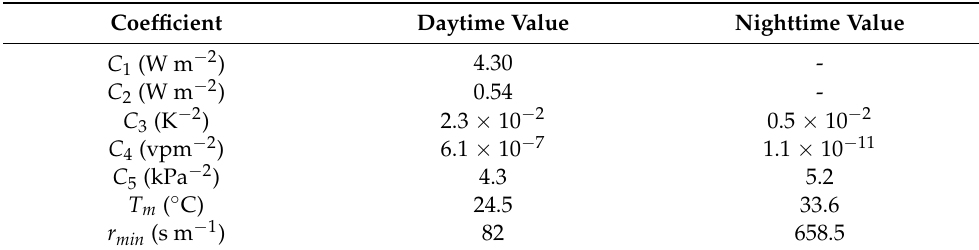
Table 1. Internal resistance parameters for the Stanghellini